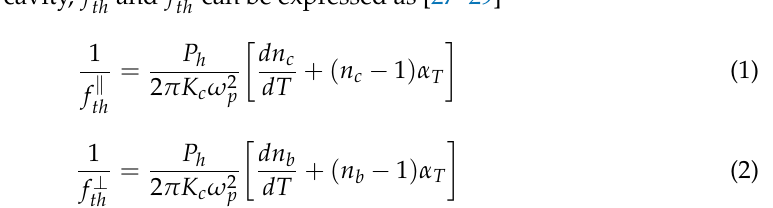
Figure 3. Experimental result for total output power, SFG output power, and fundamental and Ra- man output powers versus incident pump power with the cavity shown in Figure 1a.